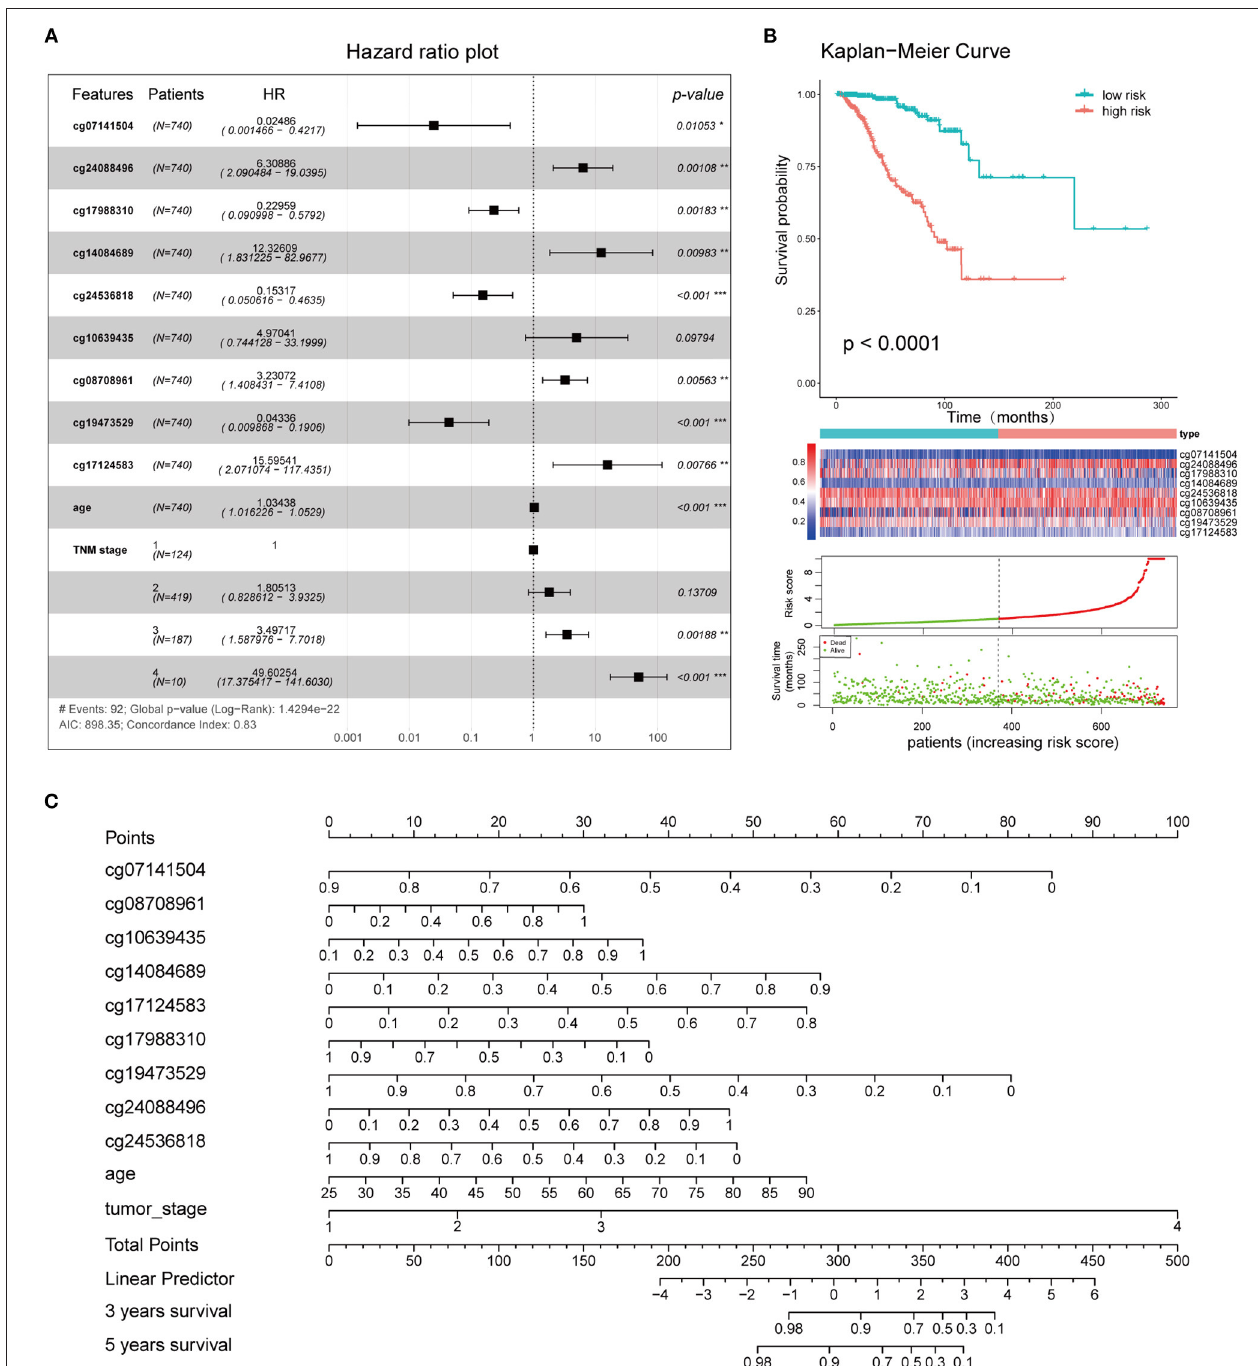
FIGURE 9 | Clinical application of the combined model. (A) Survival curves of high- and low-risk groups. (B) Forest plot showing the hazard ratios of the risk features included in the combined model. (C) Nomogram created using the 11 risk features incorporated into the combined model, to predict the 3- and 5-year OS of BC